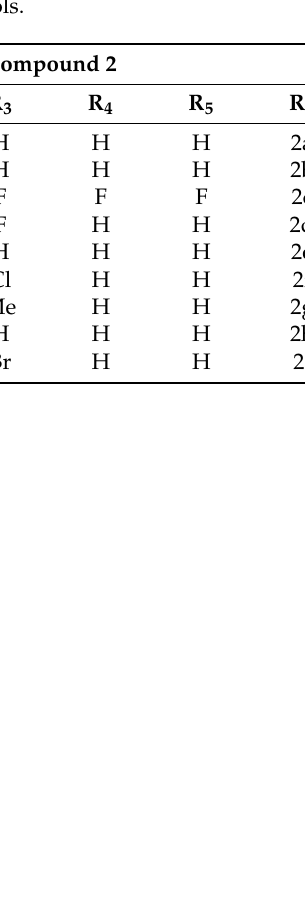
Scheme 23. Synthesis of boronates 122a , 123b , and 124 .